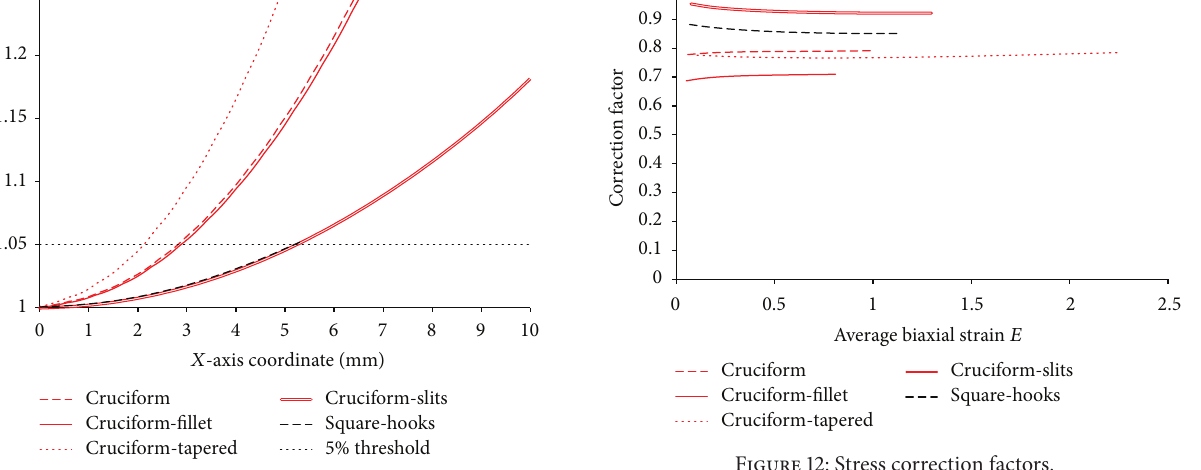
The cruciform tapered specimen presented instead a severely limited uniform area of biaxial deformation.